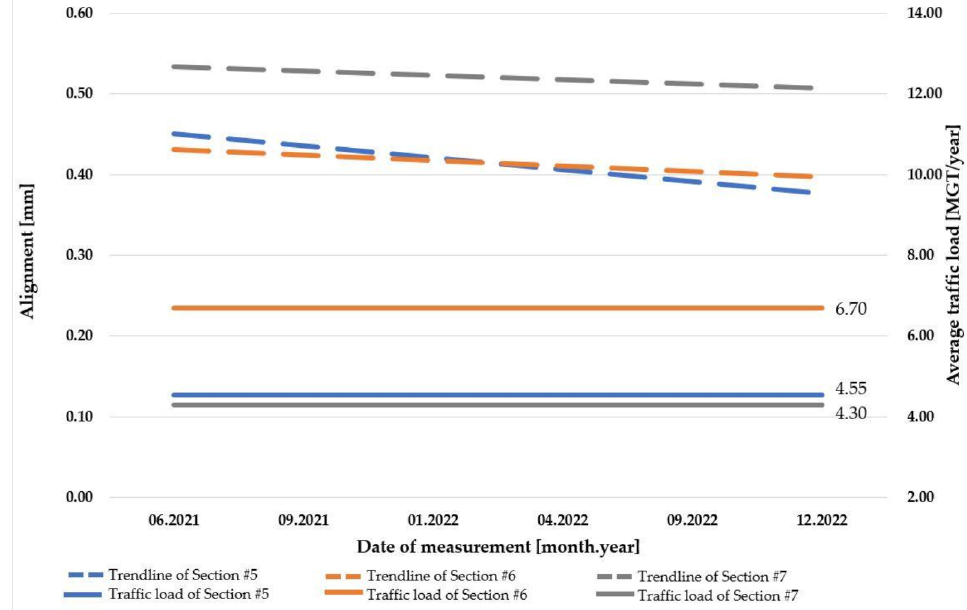
Figure 28. The relationship between alignment and traffic load in concrete slab track systems.